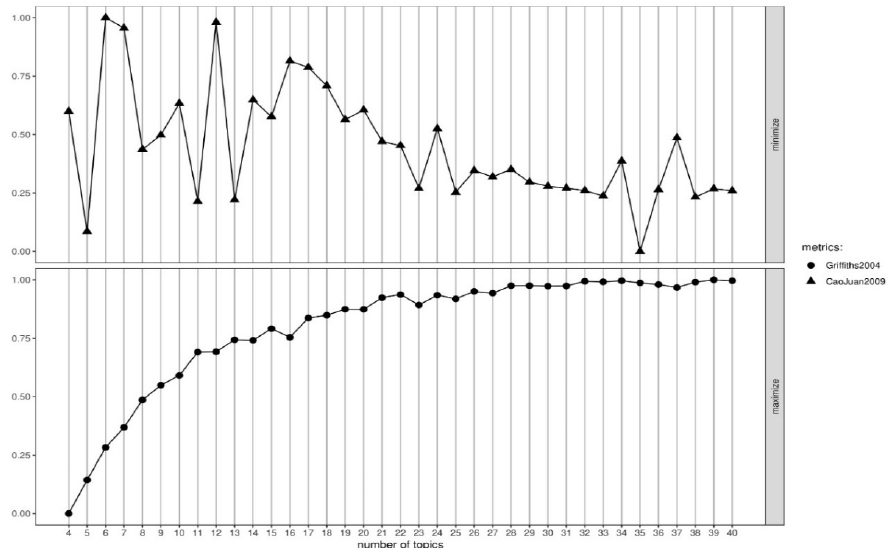
Figure A3. Find optimal number of topics.